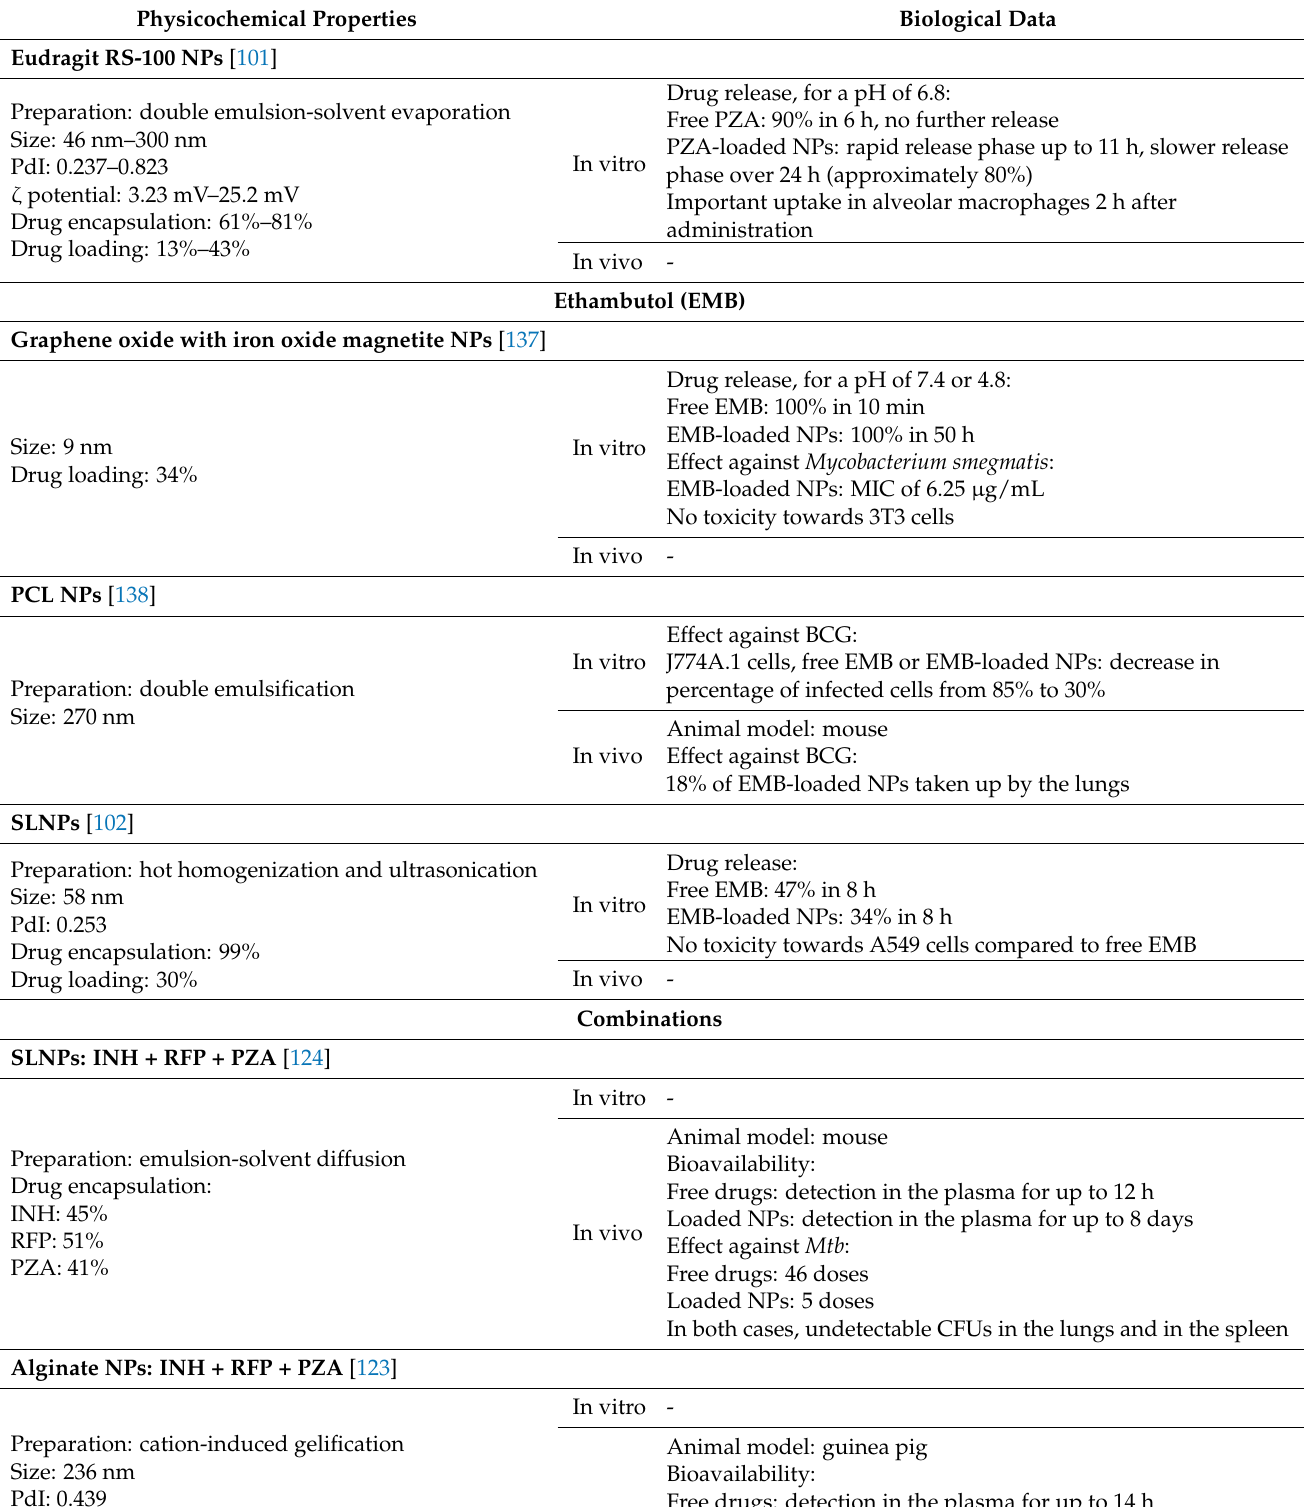
Table 1. Cont. Physicochemical